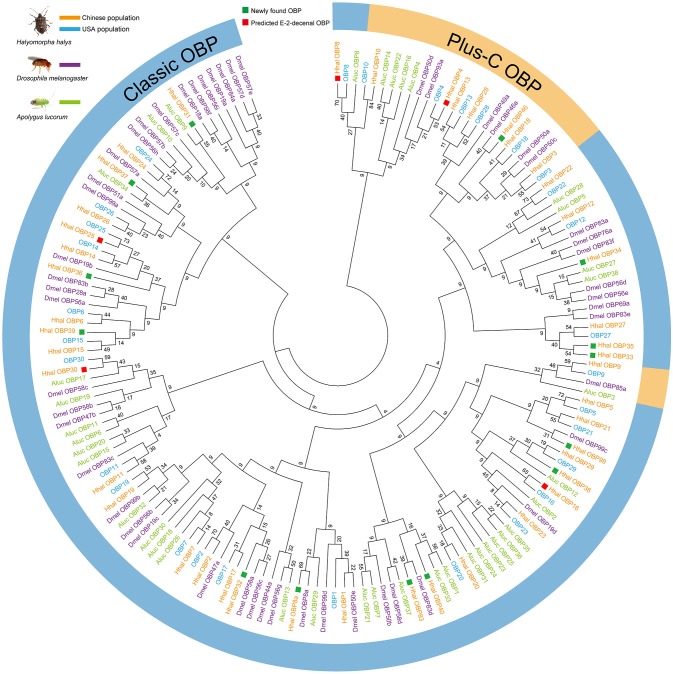
Neighbor-Joining phylogenetic tree established from candidate OBP sequences from two H. halys populations and other two insect species. The evolutionary history was inferred using the Neighbor-Joining method. The optimal tree with the sum of branch length = 95.69757843 is shown. The evolutionary distances were computed using the number of differences method and are in the units of the number of amino acid differences per sequence. The analysis involved 163 amino acid sequences. All positions containing gaps and missing data were eliminated. There were a total of 4 positions in the final dataset. Evolutionary analyses were conducted in MEGA7. Green squares showed 14 newly annotated OBPs in antennal transcriptome from Chinese strain of H. halys. Red squares indicate putative (E)-2-decenal binding OBPs (HhalOBP25, HhalOBP30, HhalOBP16, HhalOBP8, and HhalOBP4). Included are OBP genes identified from: Halyomorpha halys (Hhal: Chinese strain; OBP: USA strain), Apolygus lucorum (Aluc), and Drosophila melanogaster (Dmel). Outside circle shows predicted classic OBPs and plus-C OBPs.